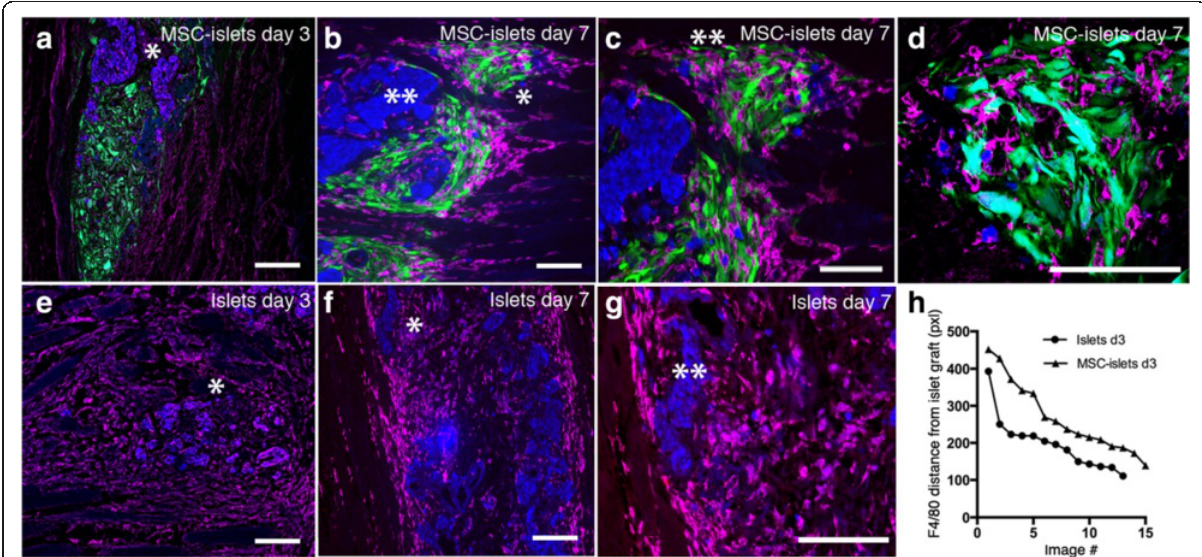
Fig. 3 Accumulation of inflammatory cells within the graft area. a The MSC (green) intermingled with F4/80 + expressing macrophages (purple) close to the islet mass (blue,*) at 3 days post transplantation. b MSC interacting (green,*) with F4/80 + macrophages (purple) at distance from the islet graft (blue,**) at 7 days post transplantation. c Increased magnification of Fig. 2b showing the interactions between F4/80 + expressing macrophages and MSC. d Close up of the MSC-F4/80 region in Fig. 3c shows MSC intermingling with the macrophages. e Infiltrating F4/80 + expressing macrophages (purple) into control islet mass (blue,*) 3 days post transplantation. f The infiltration of F4/80 + macrophages (*) into the islet graft increased even further upon day 7. g Increased magnification of the infiltrated area in Fig. 3f. h Distance of F4/80 positive cells relative to the islet graft in MSC-islets (n=4, black triangles) compared to control islet grafts (n=3, black circles) in analyzed images of the investigated animals. Bars =100